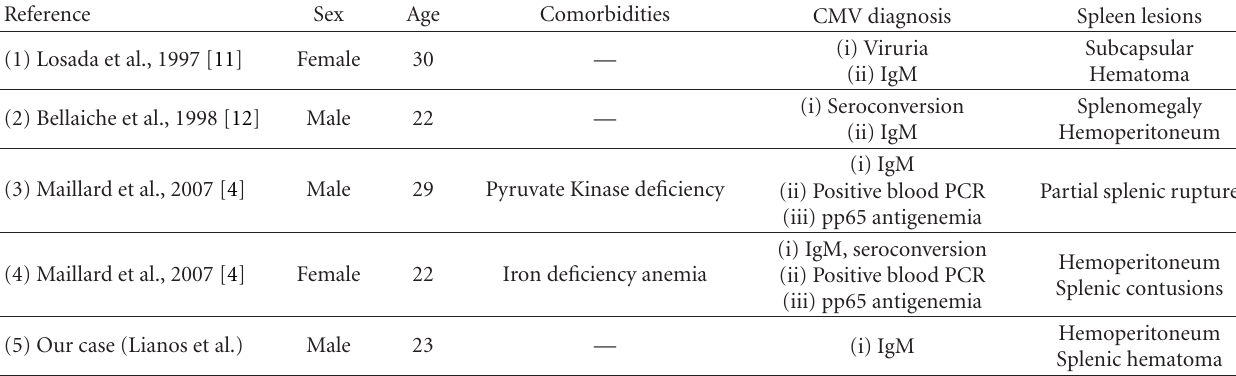
Table 1: Successful conservative management in case of splenic rupture or splenic hematoma due to CMV infection in young immunocom- petent